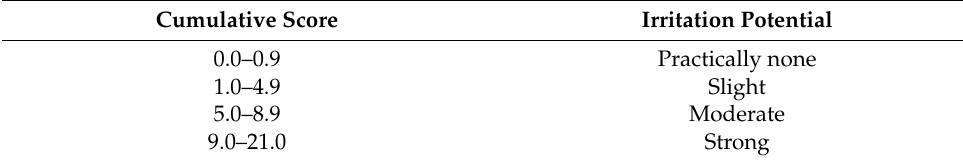
Table 2. Irritation potential interpretation of various cumulative scores